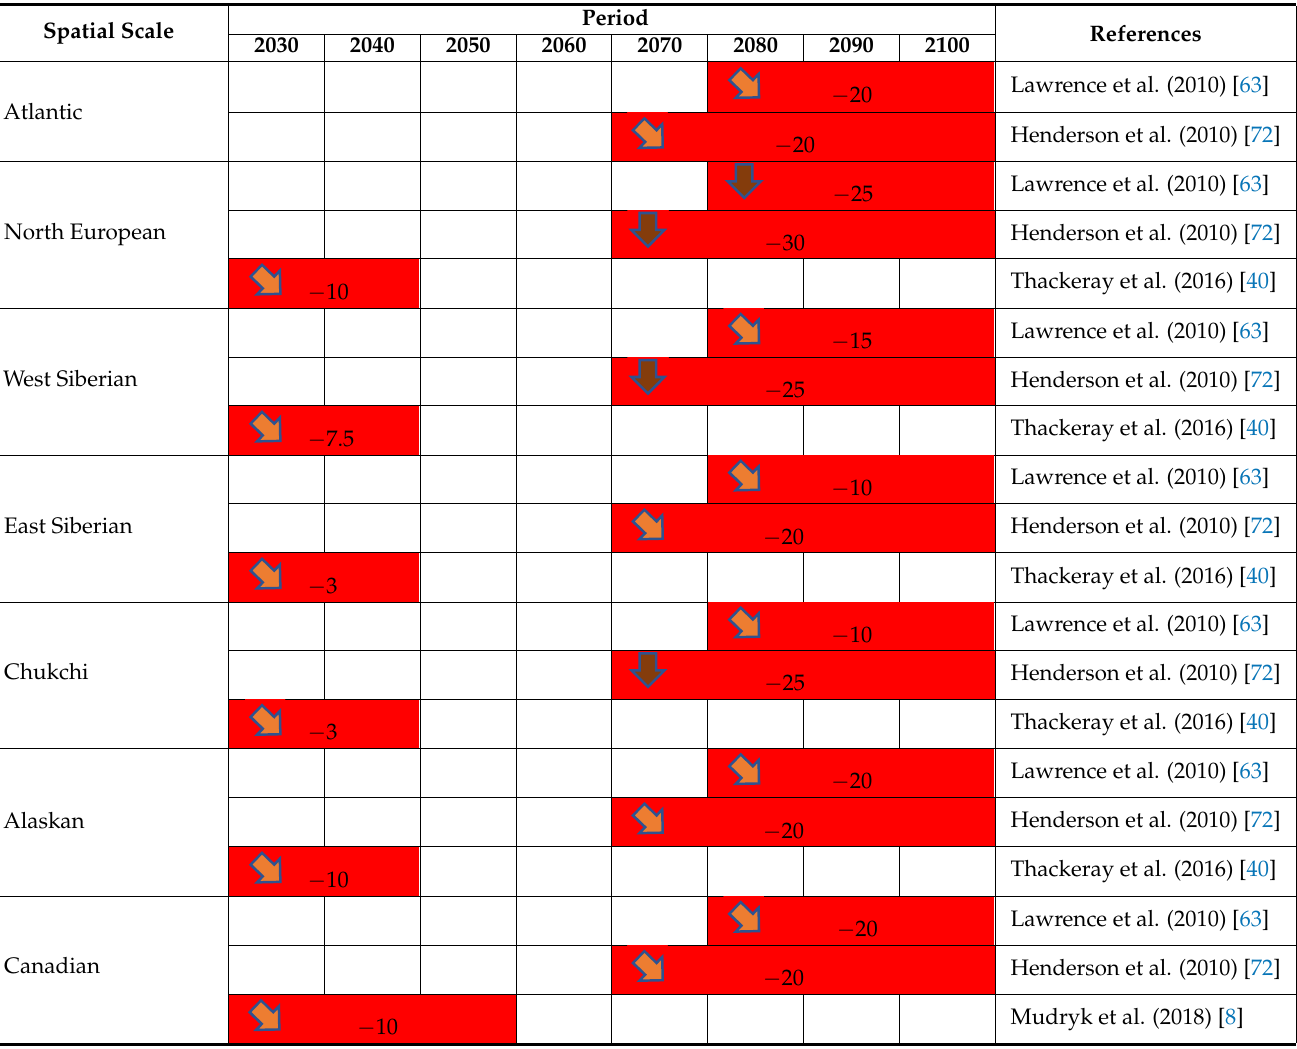
ward arrow: strongly negative; oblique downward arrow: slightly negative; horizontal arrow: no Spatial Scale Table 7. Projected relative changes in mean annual SWE under the RCP8.5 emission scenario (%)